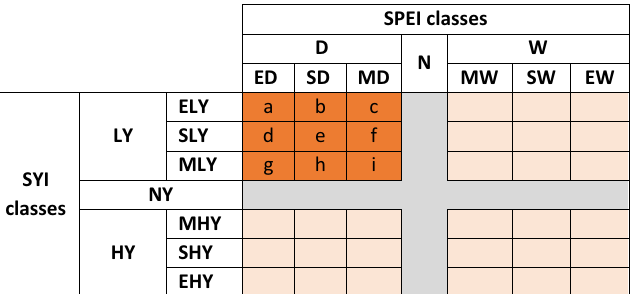
Figure 6. Contingency table among SPEI (columns) and SYI (rows) (macro)classes, see Tables 2 and 3 for acronyms in bold. Small letters in the orange side supported more in-depth analyses of the combination between LY and D macro